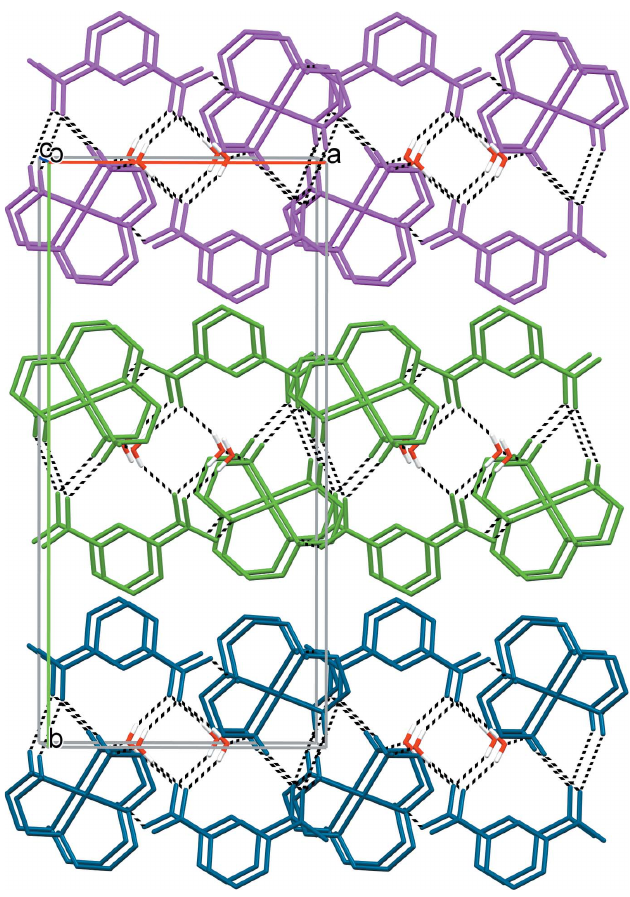
Figure 3 Side view of the bilayers in I along the c axis. C-bound H atoms and coordinated water molecules have been omitted, hydrogen bonds are shown as dashed lines.